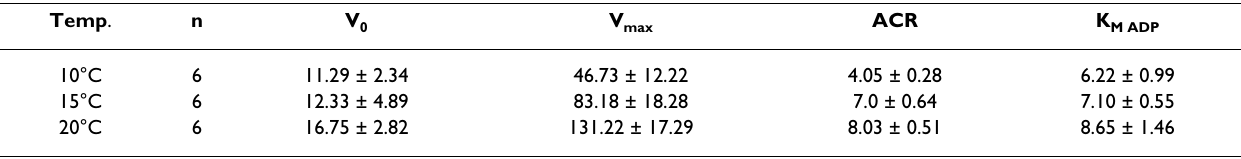
Table 5: ADP-kinetics of respiration in isolated mitochondria Temp